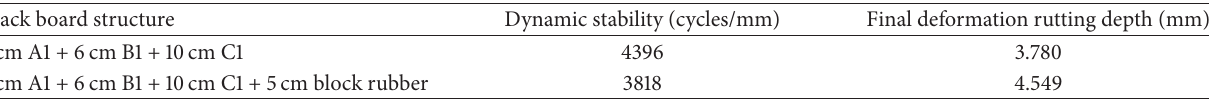
Table 4: Results of full-thickness pavement rutting